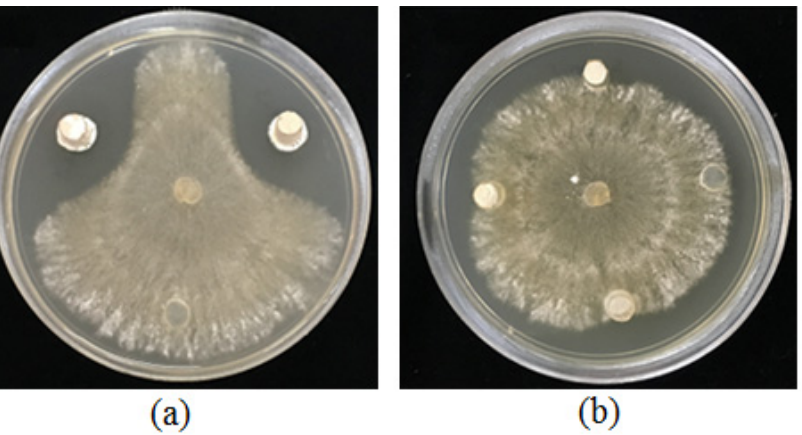
Figure 1. Bioassay results of actinomycetes isolates against Rhizoctonia solani AG4. ( a ) Clockwise from top right: actinomycetes isolate BH4-1, blank agar disk (control), actinomycetes isolate BH4-3; center: R. solani AG4; ( b ) Clockwise from top: actinomycetes isolate F8; blank agar disk (control); actinomycetes isolates 115 and R7; center: R. solani AG4.